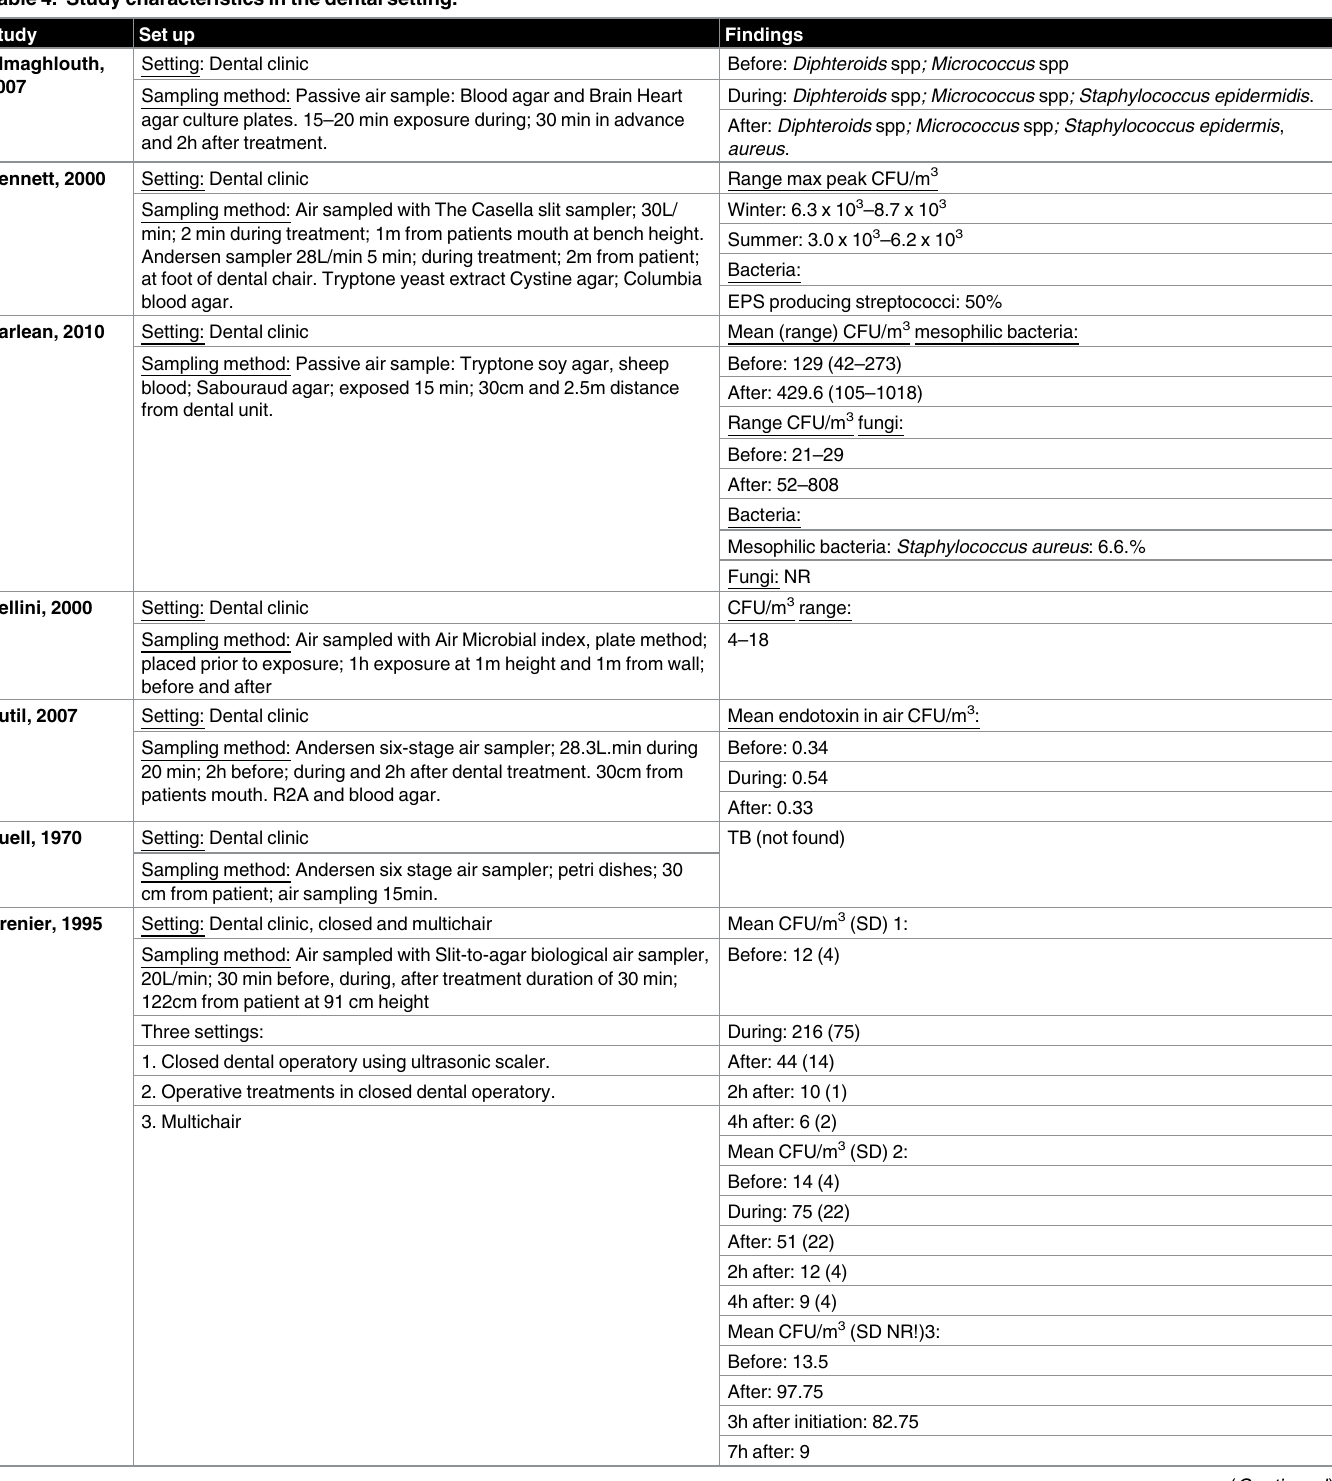
Table 4. Study characteristics in the dental setting.